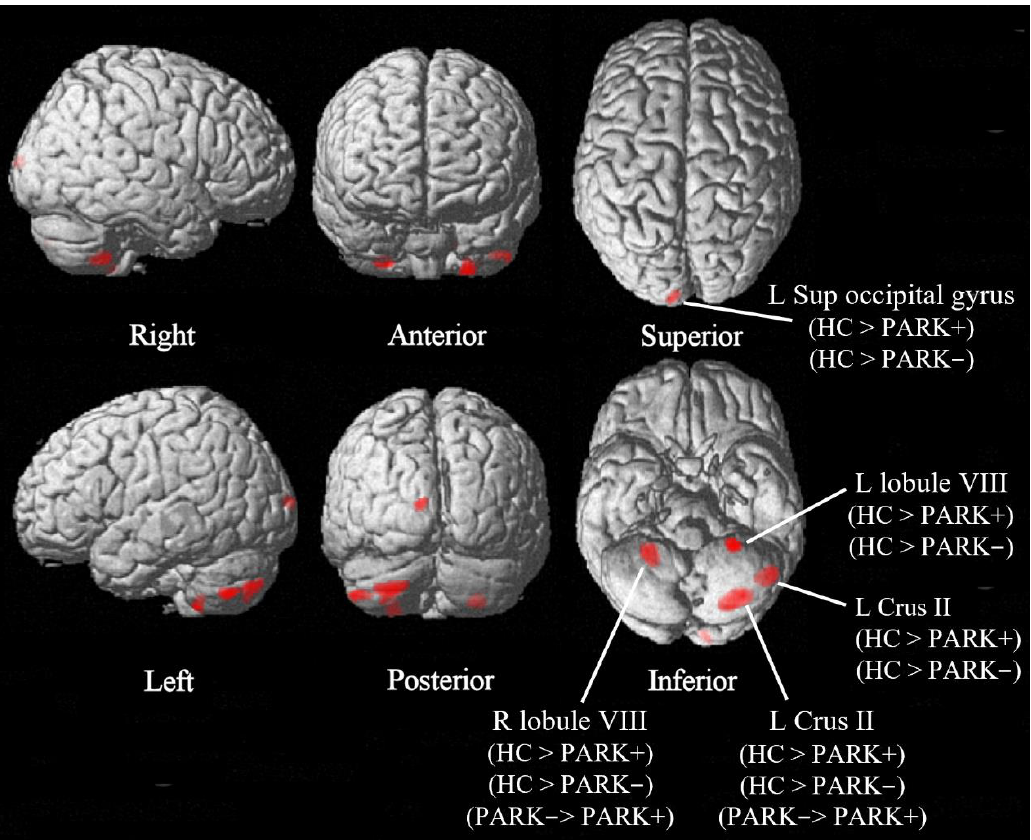
Figure 1. Voxel-based morphometry (VBM) F-test results comparing healthy controls (HCs) and 22q11.2DS patients with and without parkinsonism (Park+ and Park−). Significant group differences ( p < 0.05, family-wise error-corrected, k ≥ 20 voxels) are shown in red on a 3D render of the standard brain (six different views of the render are shown). Post-hoc analysis results are also reported for each cluster of the F-statistic image. Table 2. Voxel-based morphometry (VBM) results comparing healthy controls (HCs) and 22q11.2DS patients with and without parkinsonism (Park+ and Park−). Anatomical localization of significant ( p < 0.05 family-wise error-corrected, k ≥ 20 voxels) clusters was performed using the automated anatomical labeling toolbox of Statistical Parametric Mapping. L = left, R = right.